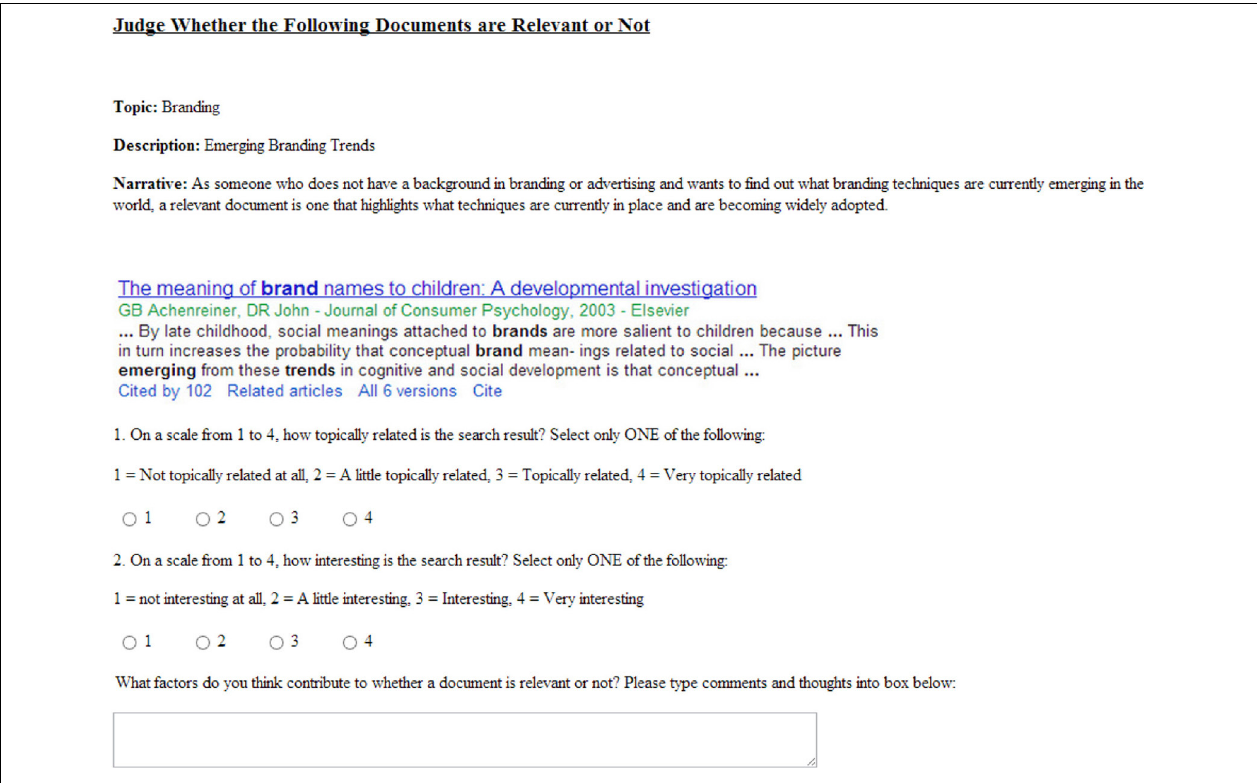
FIGURE 3 | HIT interface.